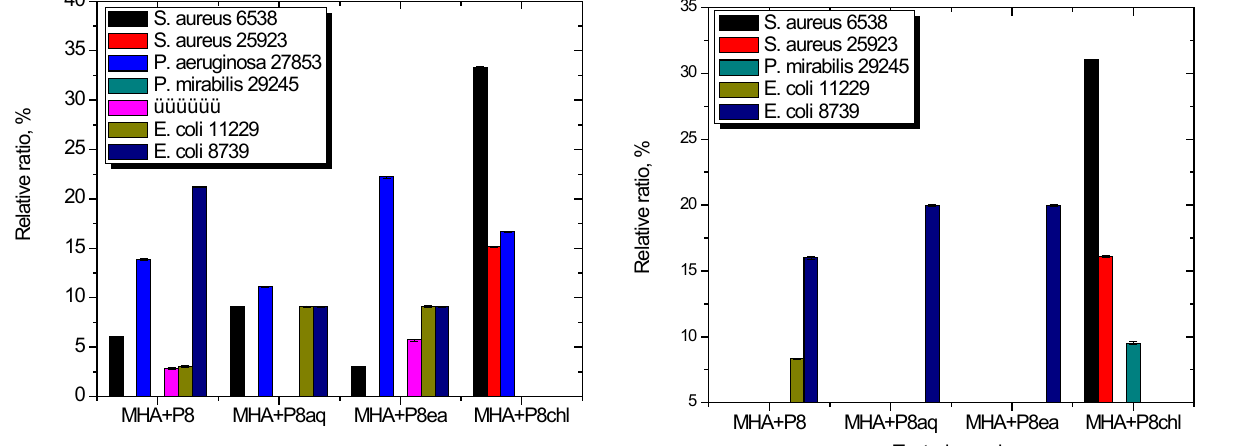
Figure 4: CIP combinations.